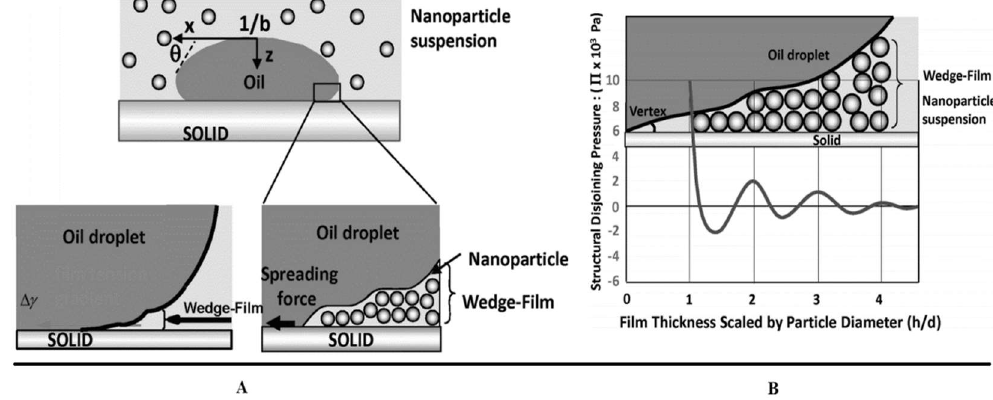
Figure 5. Wedge-shaped nanoparticle structure and forces ( A ) and wedge contact pressure ( B ). Reproduced with permission from reference. [149]. Copyright 2011 American Chemical Society.